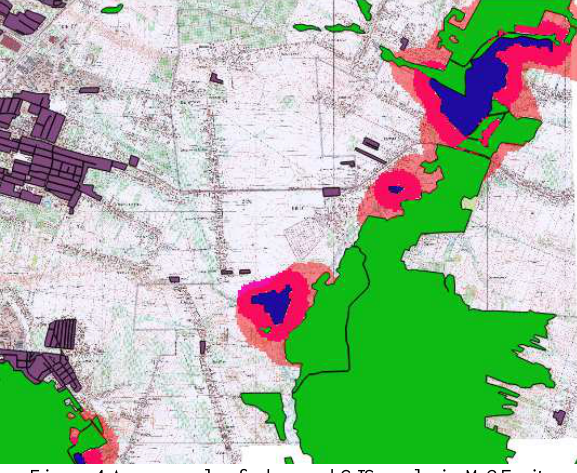
Figure.4 An example of advanced GIS analysis; MCE site location